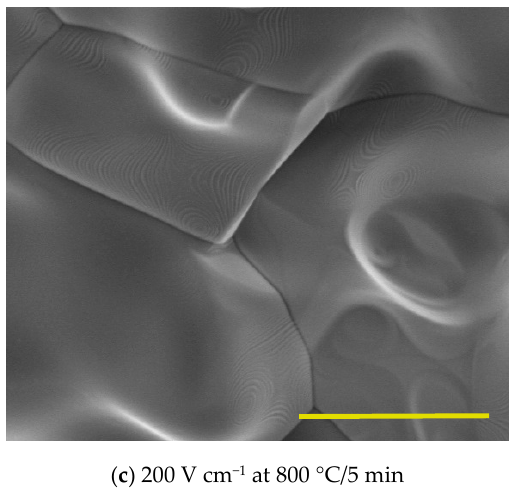
Figure 7. Scanning electron microscopy images of BITIVOX solid electrolytes ( a ) sintered at 800 ◦ C / 8 h, ( b ) sintered with 200 V cm − 1 applied at 700 ◦ C / 5 min and ( c ) at 800 ◦ C / 5 min. Bar length: 5 µm. After the scanning electron microscopy and electrochemical impedance measurements, the sintered pellets were ground in an agate mortar for using the powders for the X-ray diffraction